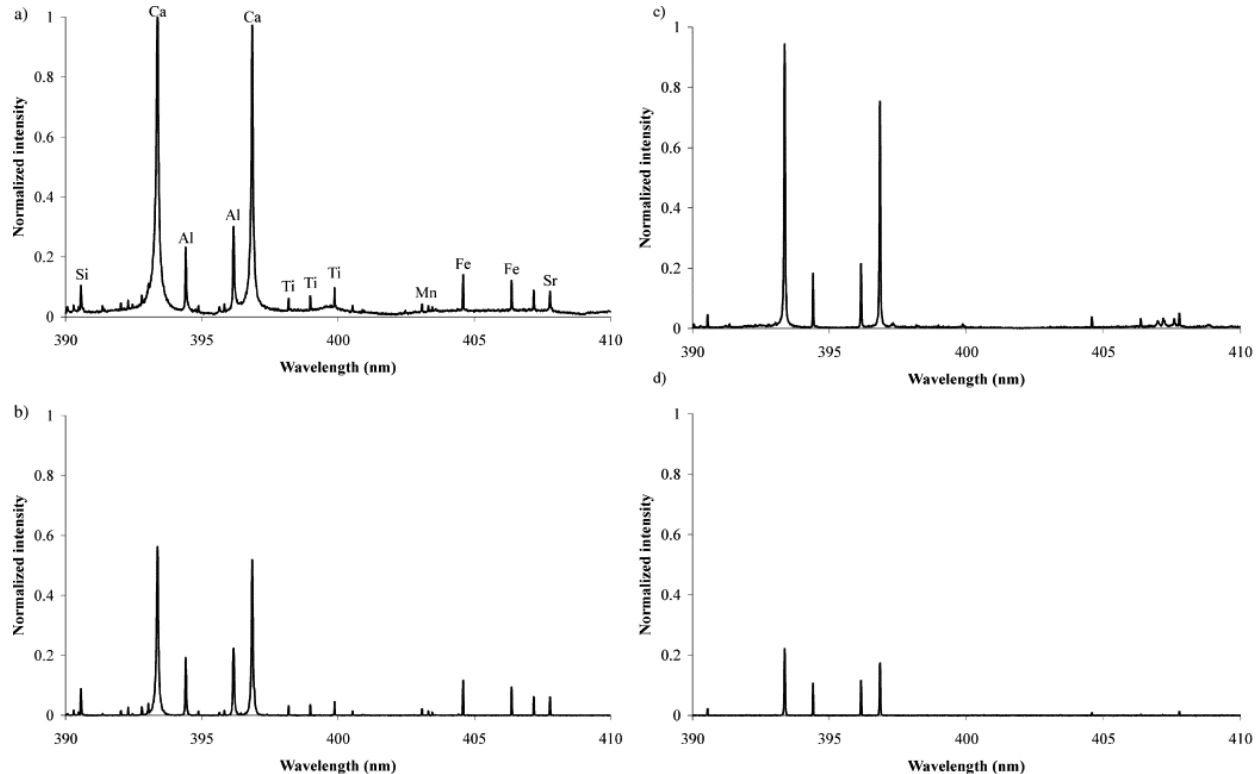
Figure 13. LIBS spectra of a soil. (a) in air no gate delay; (b) in air with gate delay of 1 with no gate delay; (d) in 7 Torr CO  s; (c) in 7 Torr CO 2 Reprinted from reference